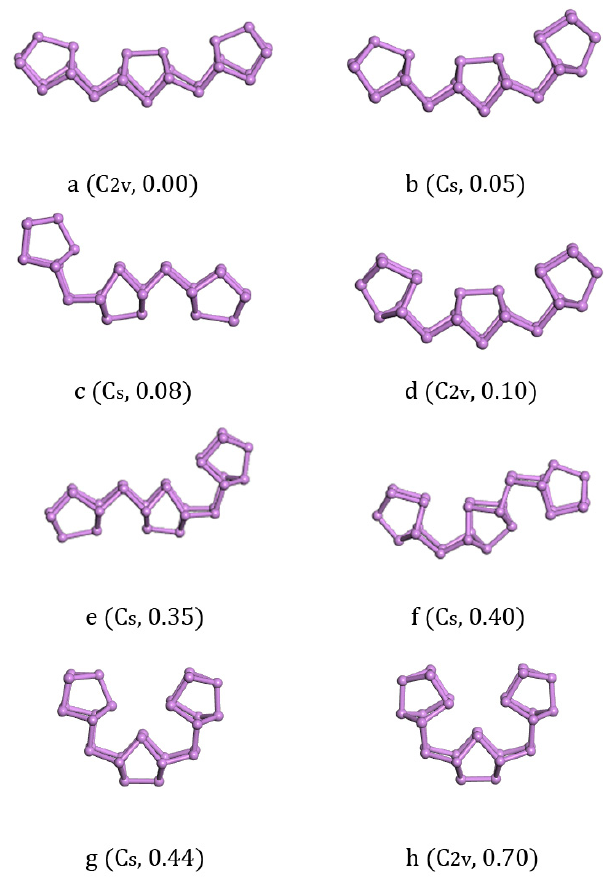
Figure 4. Lowest-energy and isomorphic structures for As 28 clusters. The relative total energies in eV.